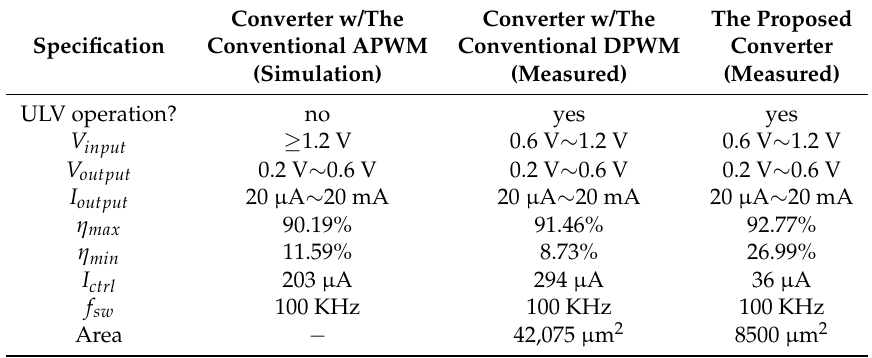
Table 1. Performance comparison of the conventional and proposed DC–DC